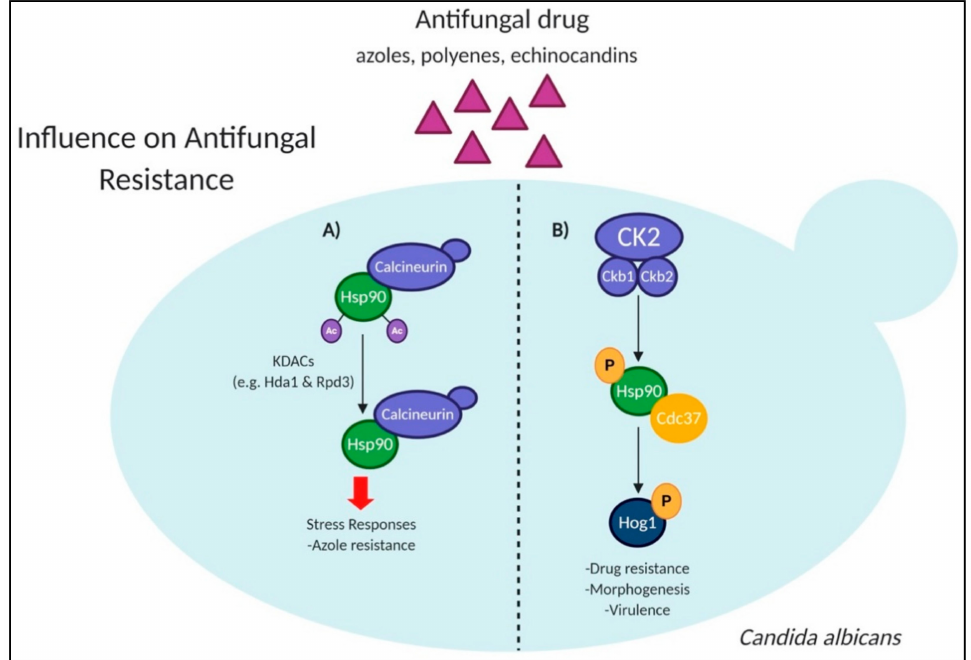
Figure 4. PTMs involved in antifungal resistance within Candida albicans. ( A ) Acetylation maintenance governed by KDACs controls the function of Hsp90 with client proteins, such as the drug-resistance regulator calcineurin, to mediate azole resistance [73,74]. ( B ) The regulatory subunits of protein kinase CK2 regulate the function of Hsp90 along with the co-chaperone Cdc37 by phosphorylation, which impacts the stability of downstream interactors, including the kinase Hog1 [75]. KDAC: lysine deacetylase; Ckb1/2: regulatory subunits of protein kinase